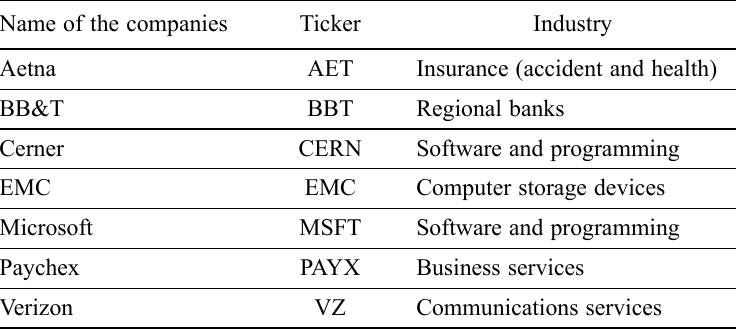
Table 1. Firms with the best training program from 2006–2011 Name of the